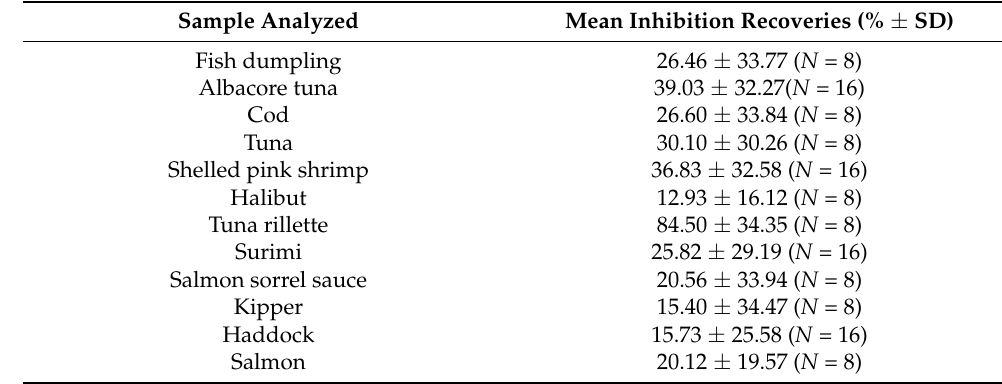
Table 5. Mean inhibition rates for HAV, HEV, and norovirus according to fish samples analyzed.